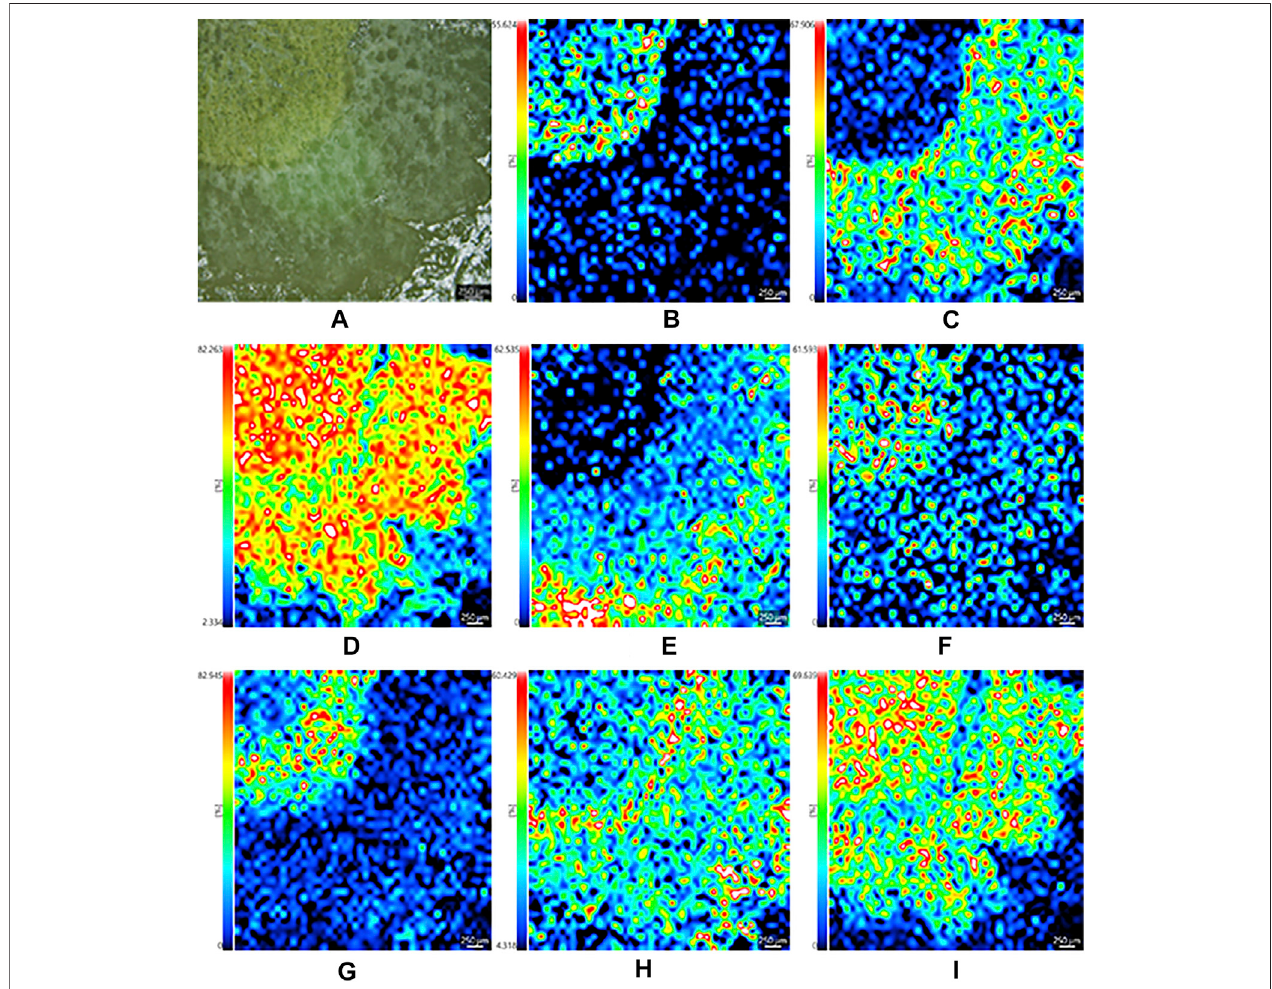
FIGURE 3 | Optical image of the dried root of Isatis indigotica (A) and the mass spectrometry images of the positive ions of oxindole (B) , 3-[2 ′ -(5 ′ -hydroxymethyl) furyl]-1(2 H )-isoquinolinone-7-O- β -D-glucoside (C) , coniferin (D) , guanine (E) , histidine (F) , proline (G) , arginine (H) , and cyclo ( L -Phe – L -Tyr) (I) .